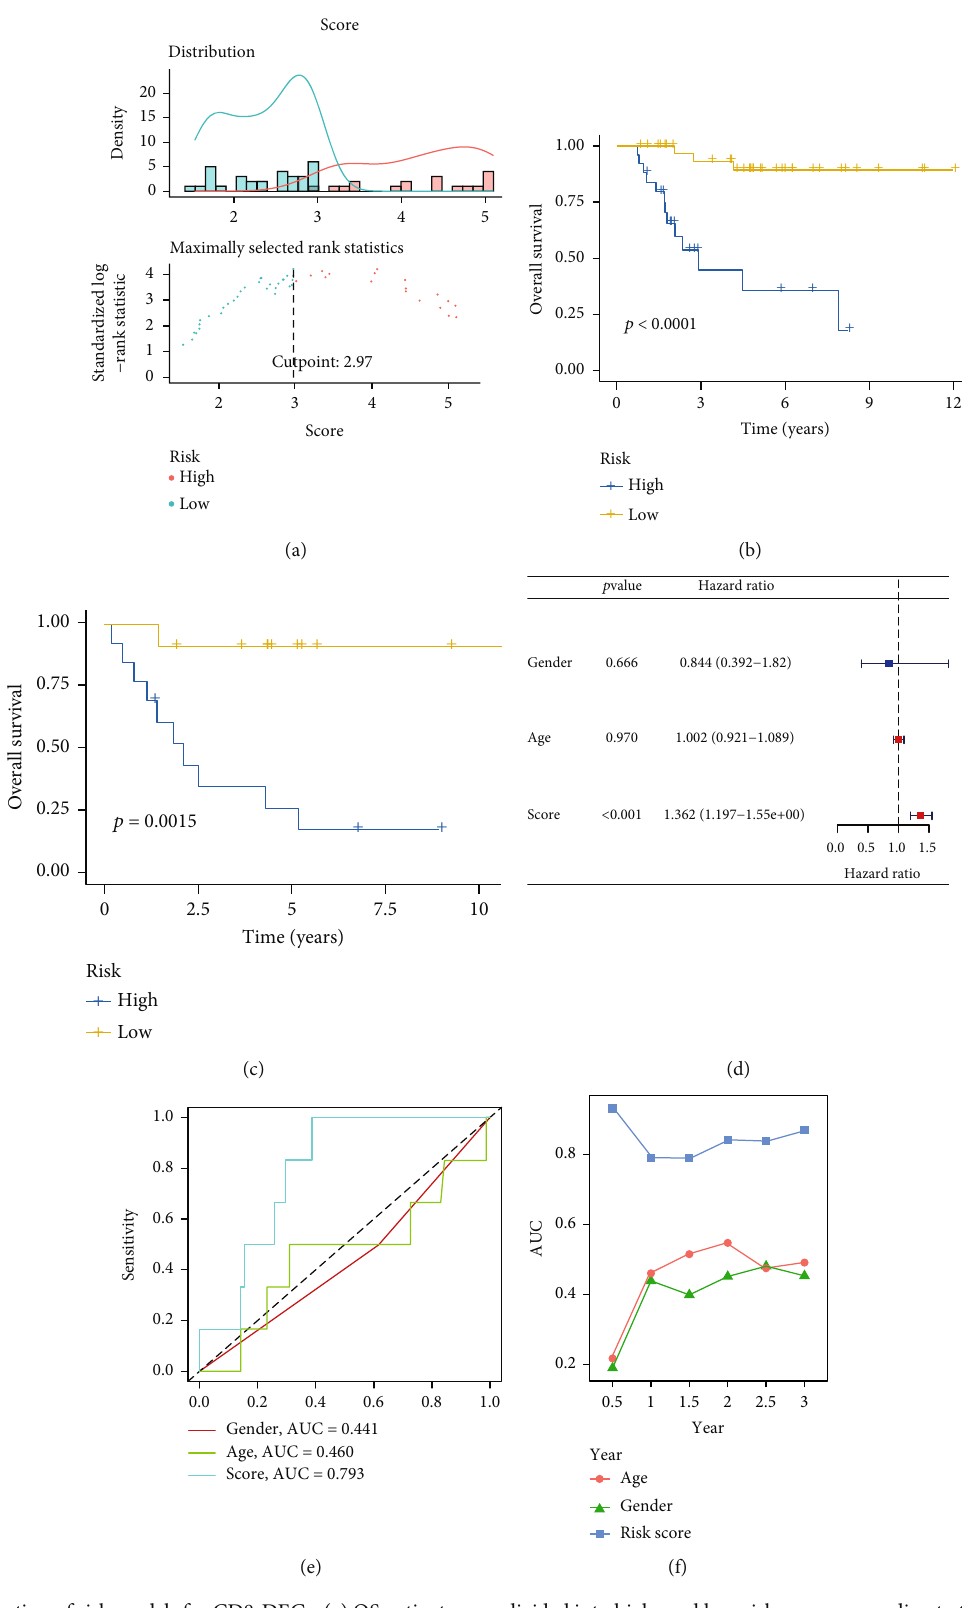
Figure 4: Evaluation of risk models for CD8-DEGs. (a) OS patients were divided into high- and low-risk groups according to the optimal cuto ff (2.97) value. (b, c) Comparison of OS between high- and low-risk scores in the training and validation cohorts. (d) Univariate analysis of CD8- DEG risk scores and clinical characteristics. (e, f) Comparison of the predictive power of CD8-DEG risk models and their clinical